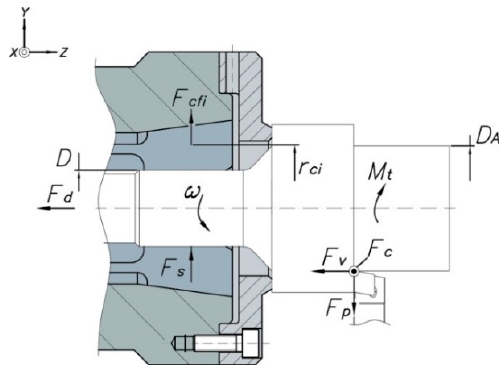
Figure 8. Forces acting in collet chuck holders.